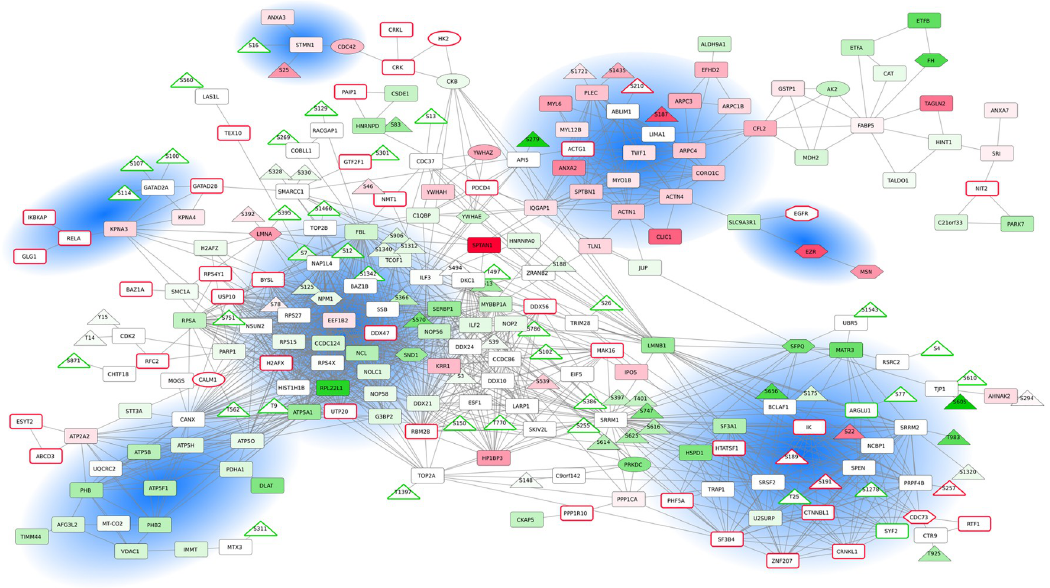
Fig 4. Network of CR biomarker interactions. Proteins (boxes) and phosphosites (triangles) significantly upregulated or downregulated in the CR context are mapped in red or green, respectively, with color intensities related to fold-changes. For visualization purposes, the expression values correspond to the mean of the expression of PC3 and DU145 cell lines. Proteins and phosphosites identified only in CR (DU145 and PC3) or CS (LNCaP) cells lines are squared in red and green, respectively.